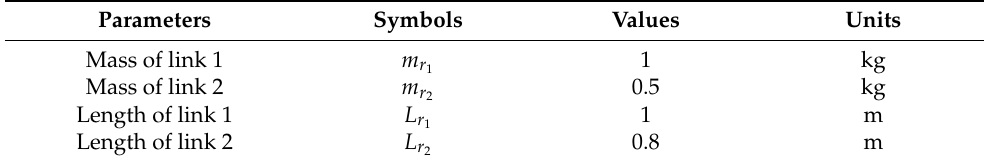
Table 5. Two-link robot arm parameters.